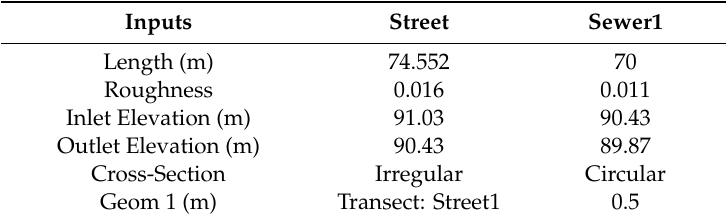
Table 2. Input parameters for the street and the sewer.